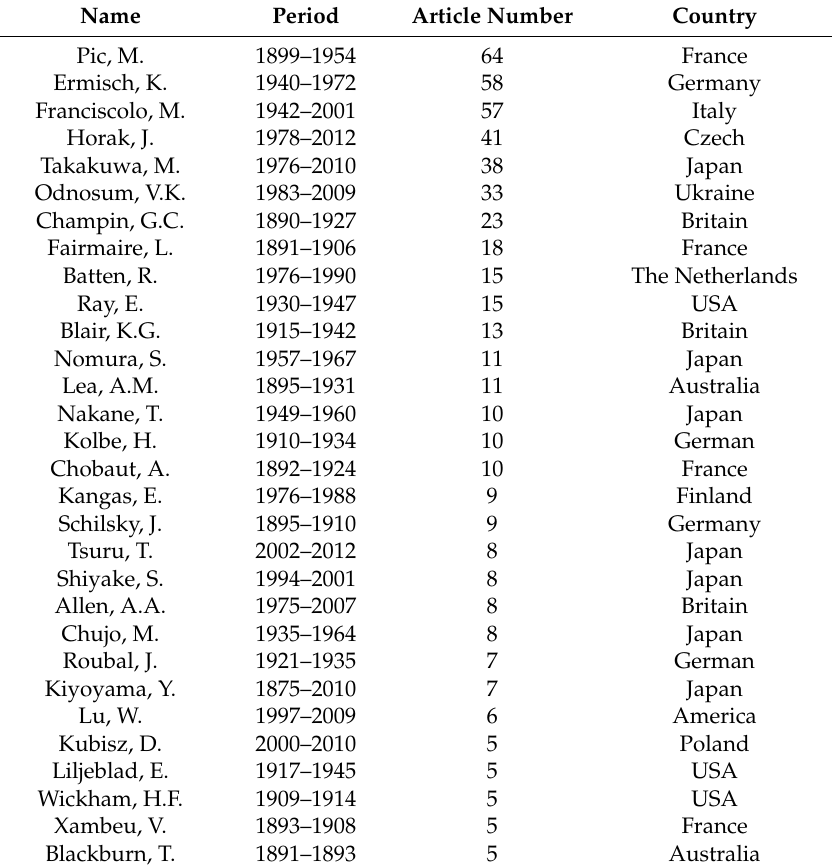
Table 2. The distribution of articles by primary authors, years, and